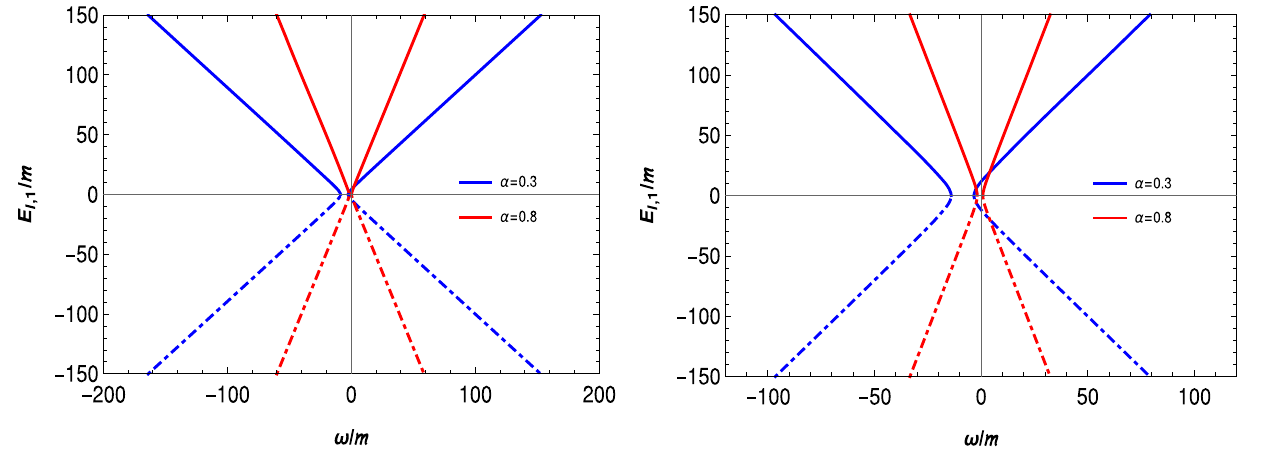
Fig. 4 In both graphs contained in the figures on the right and left, we | as a function of ω/ m . In the figure on the left, we have the have | E l , 1 m setting of the parameter ξ = 0 . 1 and two values of the parameter α . The continuous curves represent the positive sign of the spectrum Eq. (35)